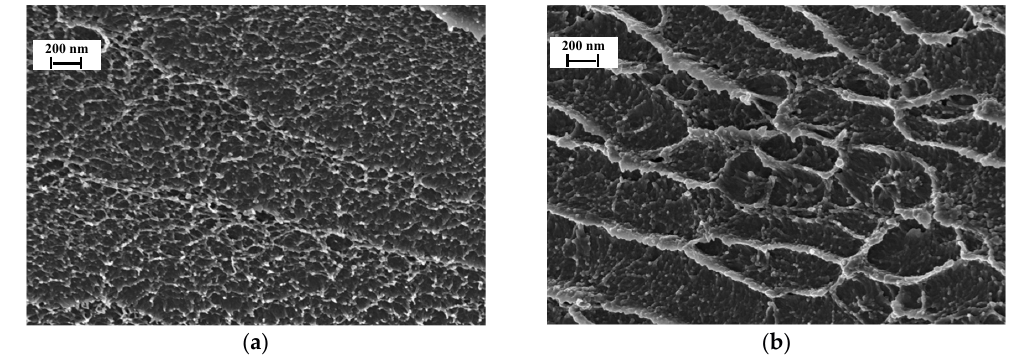
Figure 3. SEM micrographs of the membrane cross-section: ( a ) P84, ( b ) P84/ND.